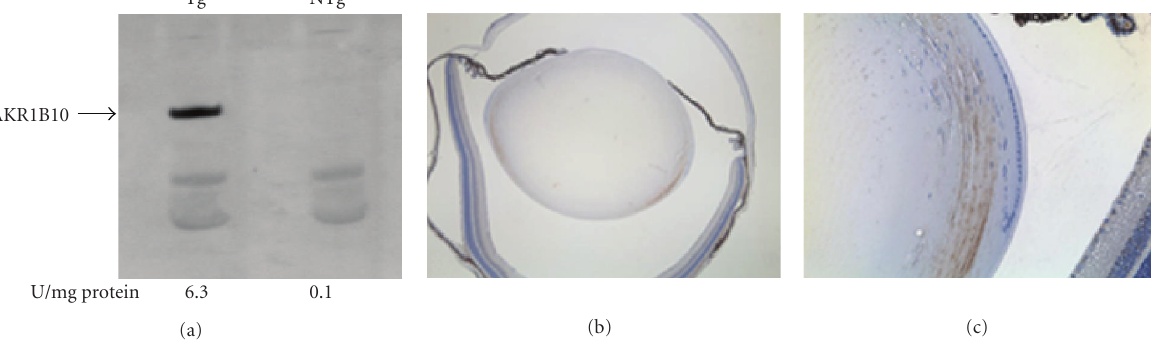
Figure 3: AKR1B10 expression in the transgenic lens. (a) Western blot demonstrating expression of AKR1B10 in lens of transgenic (Tg) mice; the characteristic band was not observed in lenses from nontransgenic (NTg) controls. Aldo-keto reductase enzyme activity in lenses is shown below each lane. (b) and (c) Immunohistochemical stain for AKR1B10 expression in the transgenic